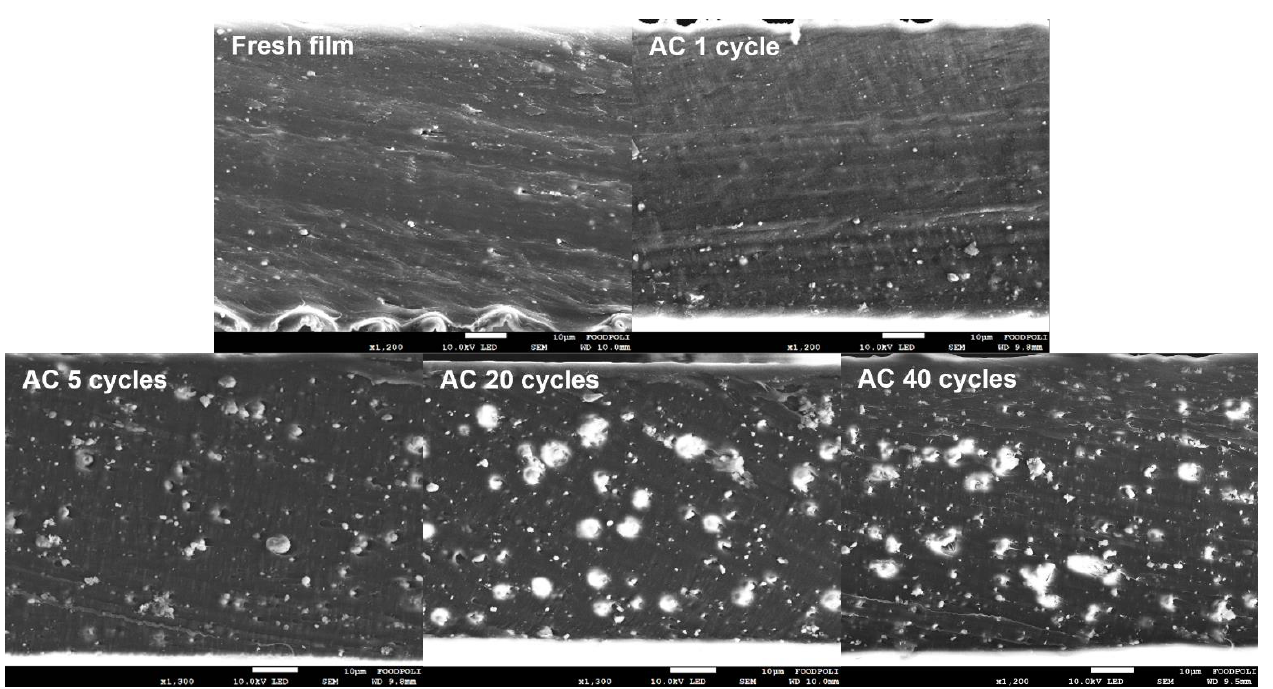
Figure 5. FE-SEM images of the cross-section of films treated with AC after different number of test cycles.